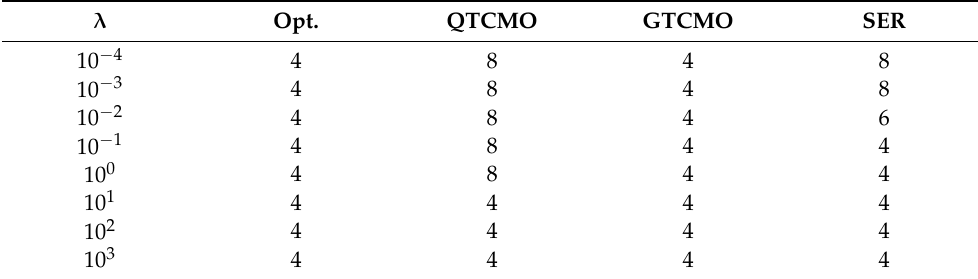
Table 3. The resulting total number of edges with the proposed sparsifying algorithms for λ . λ Opt. QTCMO